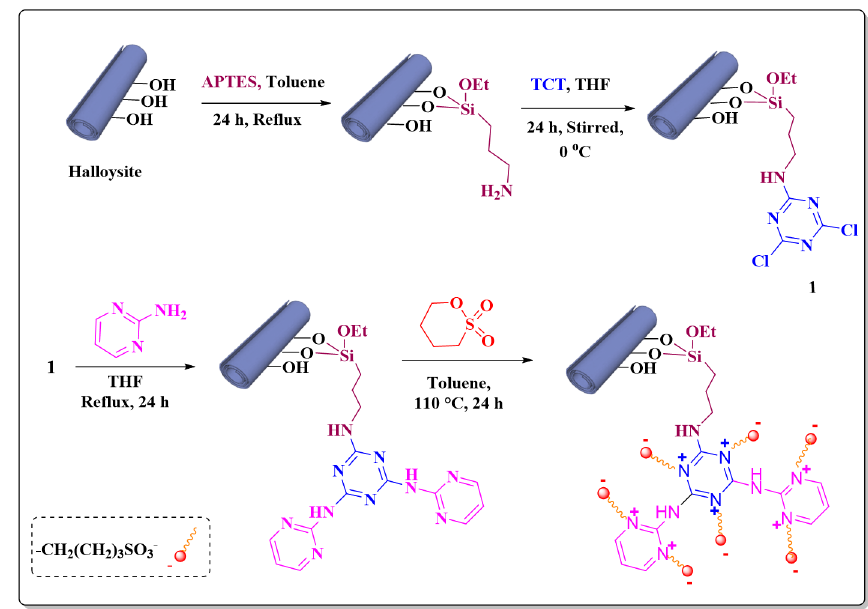
Figure 1. Procedure for the preparation of Hal-Py-IL.